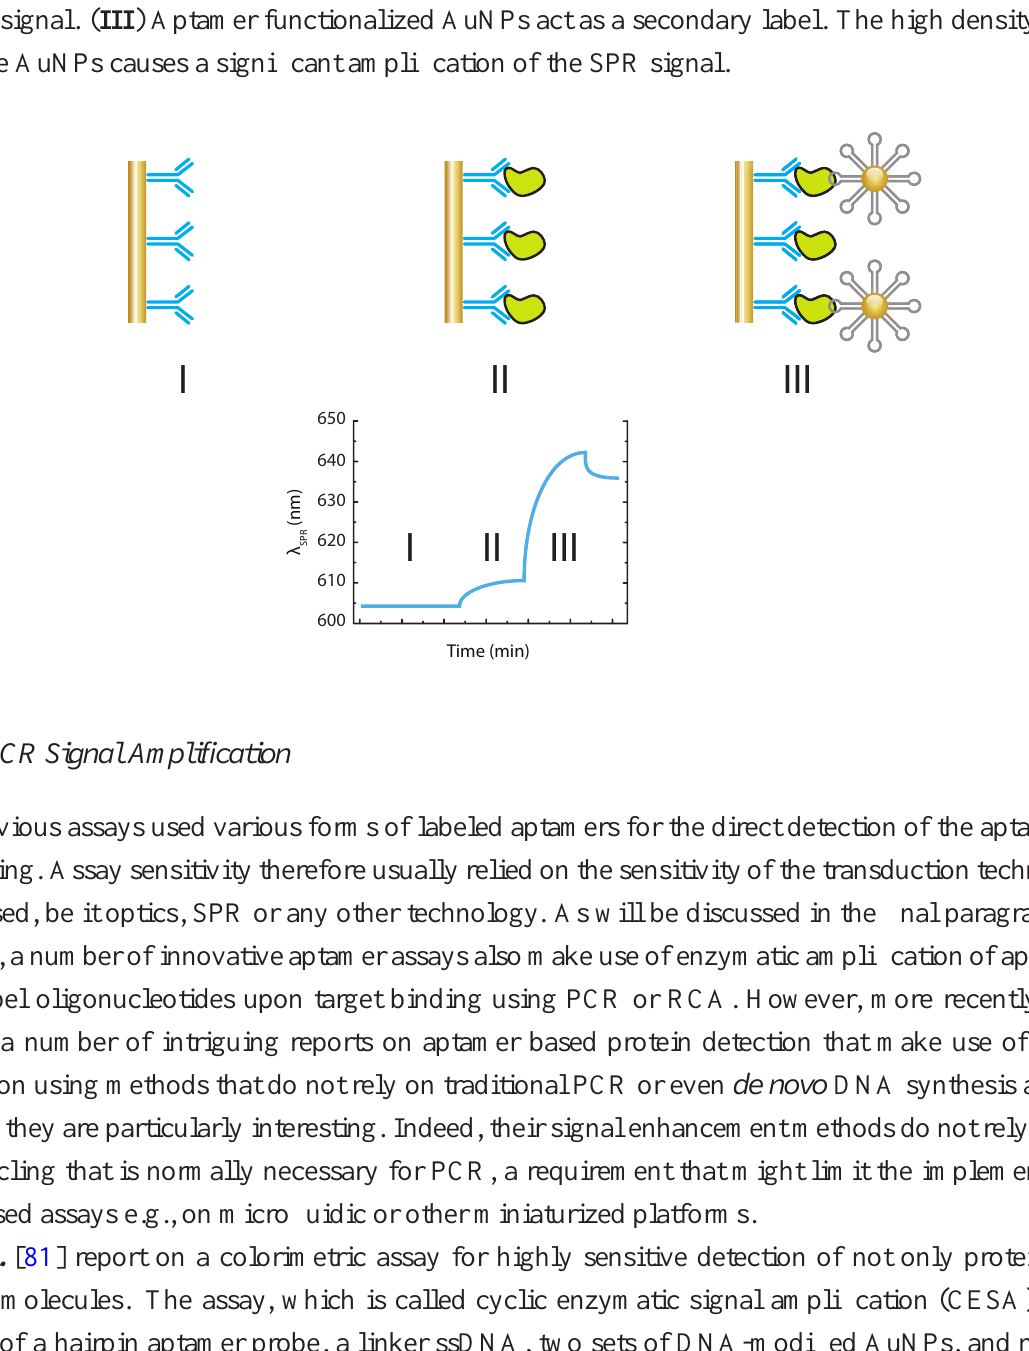
Figure 15. A schematic representation of the PCR sandwich immunoassay for the ultrasensitive detection of hIgE that utilizes AuNPs–aptamer conjugates as amplification reagent